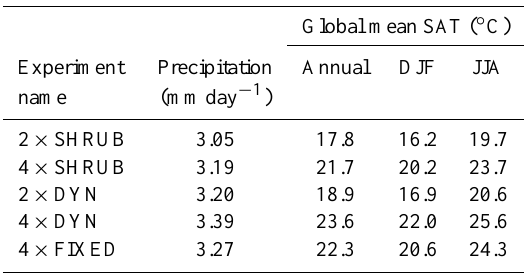
Table 3. Table showing climatological means for all Eocene